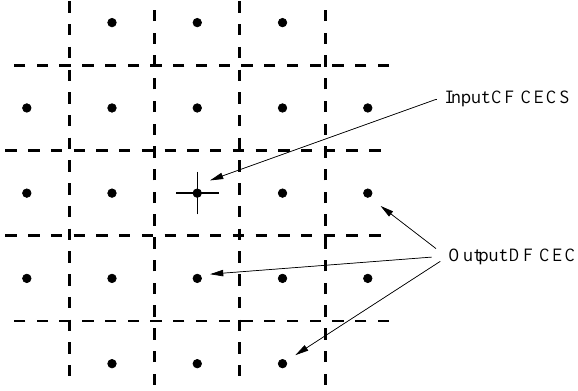
Fig. 2. The calculation grid used in Sect. 2.2. Note that in general the grid need not be